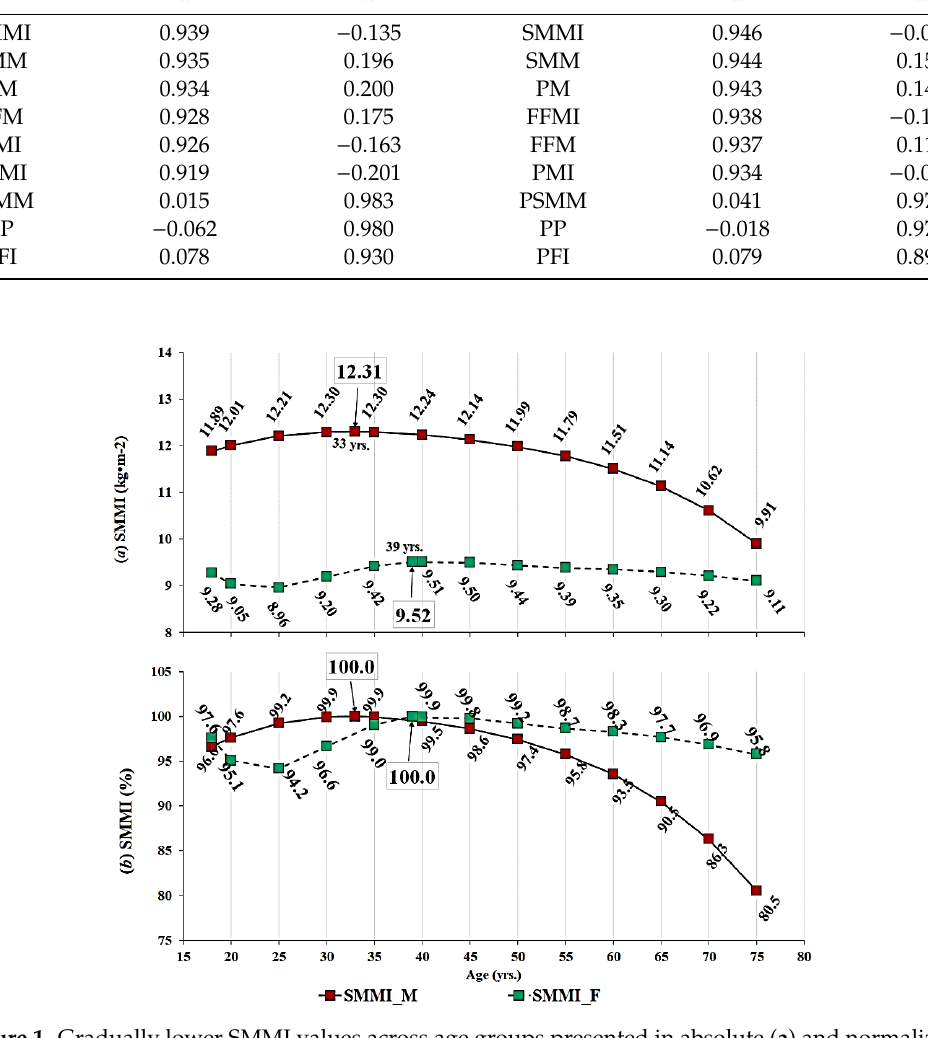
Figure 1. Gradually lower SMMI values across age groups presented in absolute ( a ) and normalized ( b ) ( b ) values.